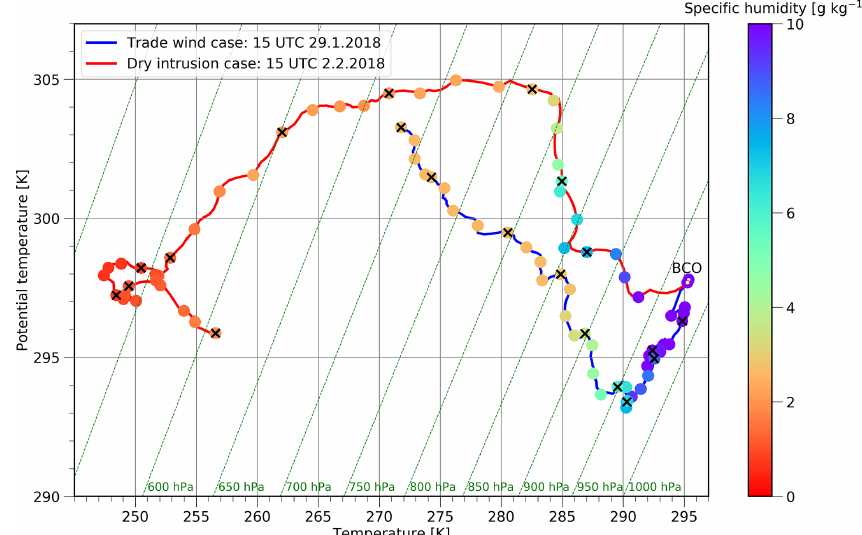
Figure 15. Thermodynamic θ – T diagram summarising the 10d Lagrangian history of the air parcels that arrived in the sub-cloud layer ( p > 940hPa) above Barbados at 15:00UTC on 29 January 2018 (blue line, extratropical trade wind regime) and at 15:00UTC on 2 February 2018 (red line, extratropical dry intrusion regime). Values are shown every 6h and averaged over the 40 sub-cloud layer trajectories. The colours of the filled circles indicate the specific humidity of the air parcels every 6h. The arrival conditions above Barbados are indicated by white dots; the black crosses indicate daily time steps backwards in time. The slanted green lines show isobars, the horizontal lines isentropes and the vertical lines